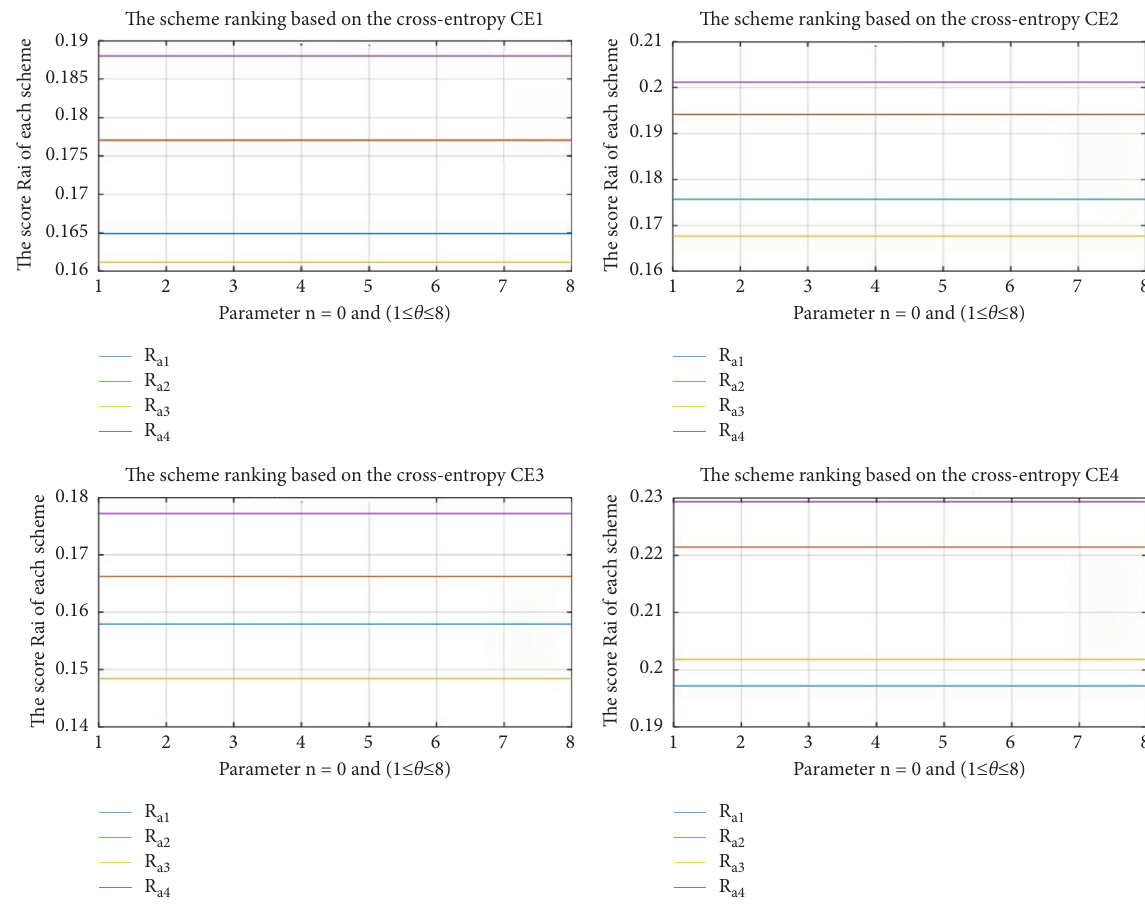
Figure 11: Ranking score of each alternative based on parameters n � 0, 1 ≤ θ ≤